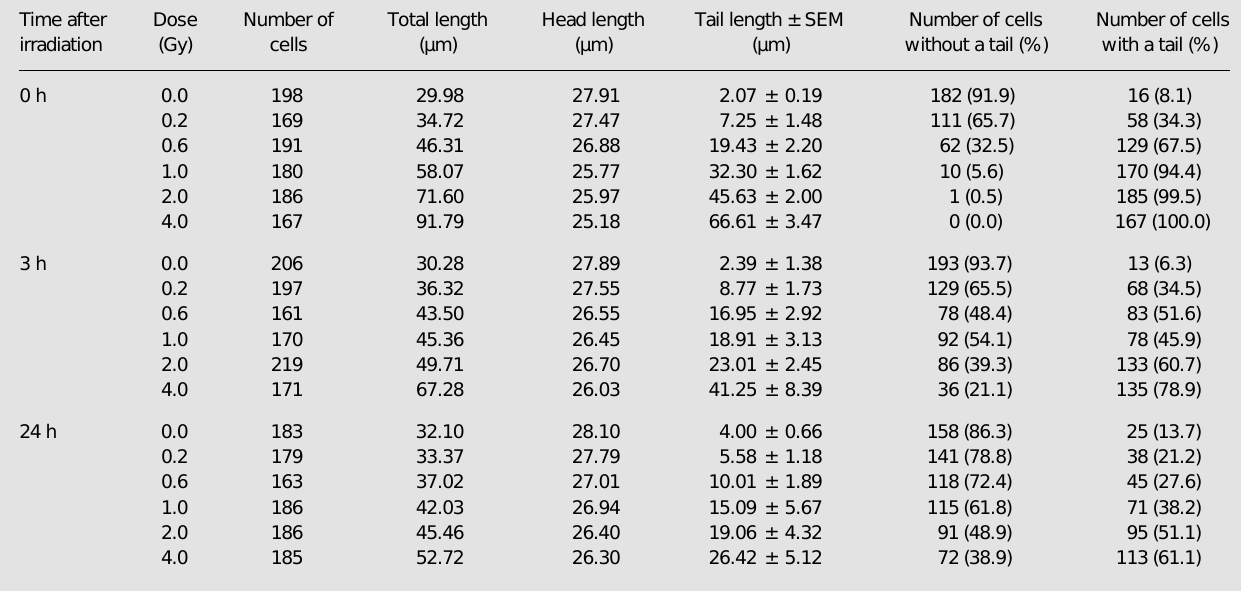
Table 3 - Mean values of comet length (head and tail) obtained for blood samples from 3 breast cancer patients, processed immediately or 3 and 24 h after in vitro exposure to 60 Co. Tail length = Total length - head length.